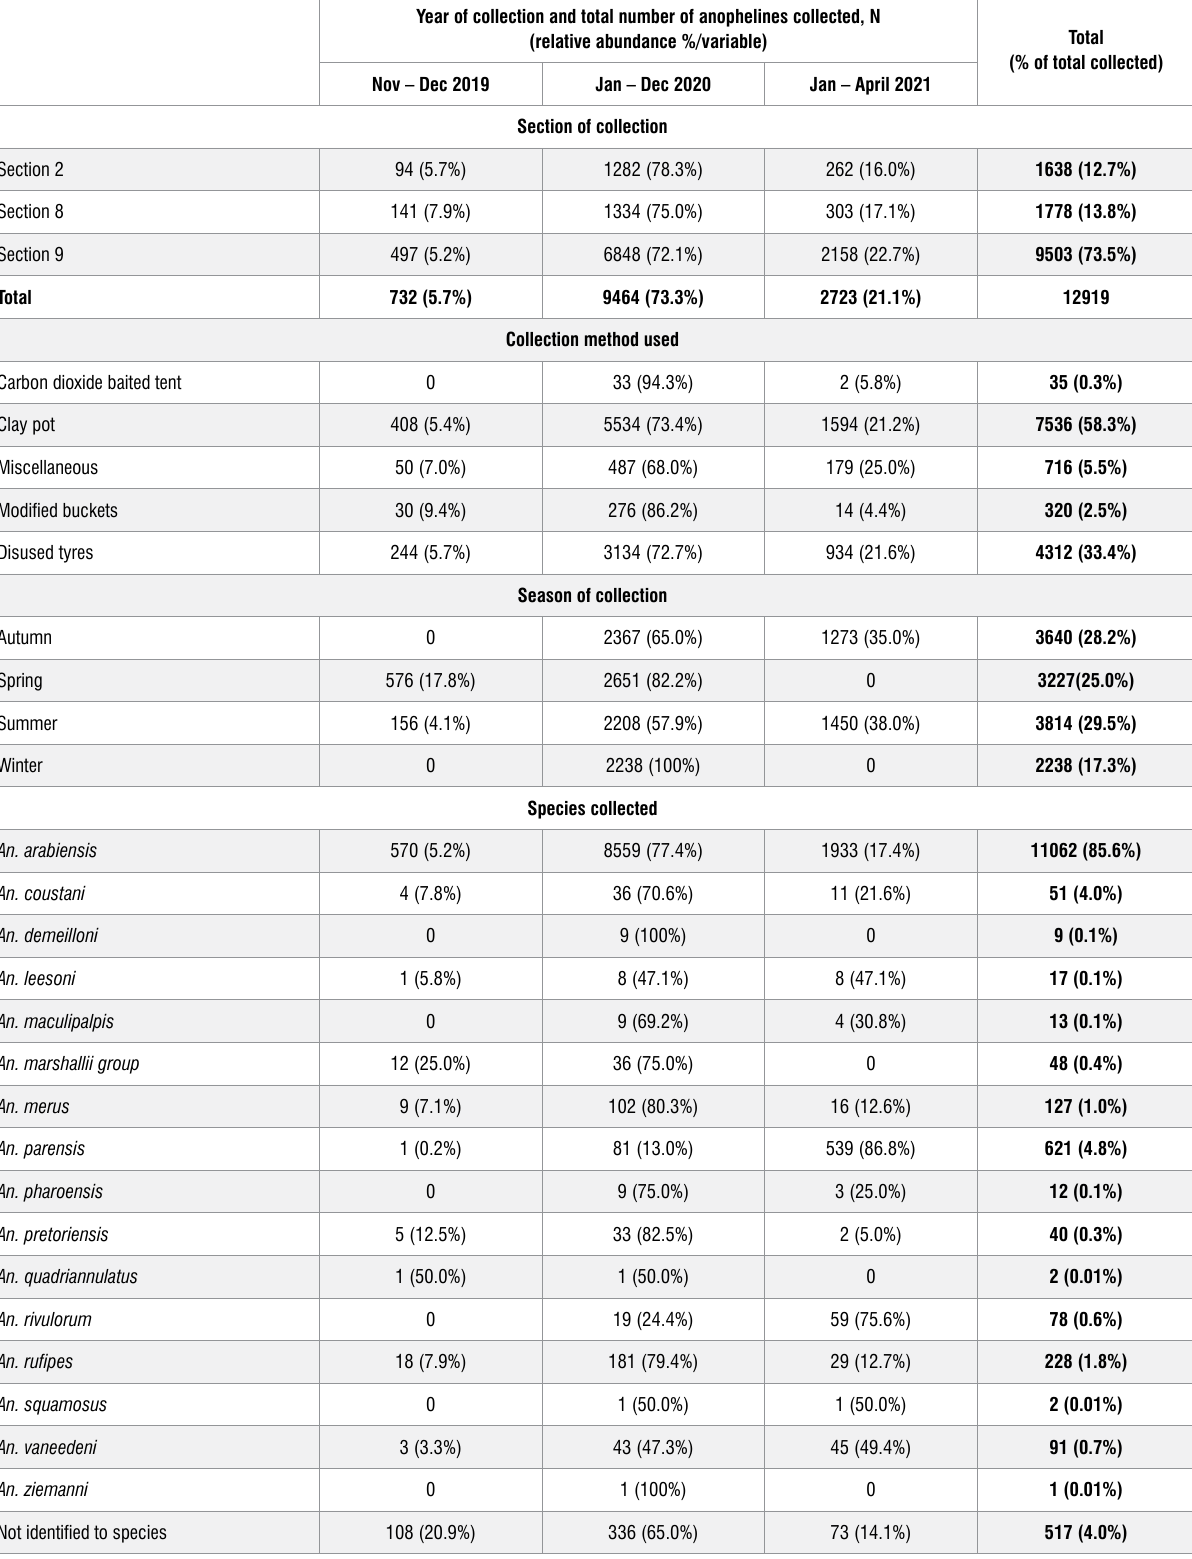
Table 1: Anopheles mosquitoes sampled from Mamfene, northern KwaZulu-Natal, South Africa, between November 2019 and April 2021, stratified by section, year of collection, season and species Year of collection and total number of anophelines collected, N (relative abundance %/variable) Total (% of total